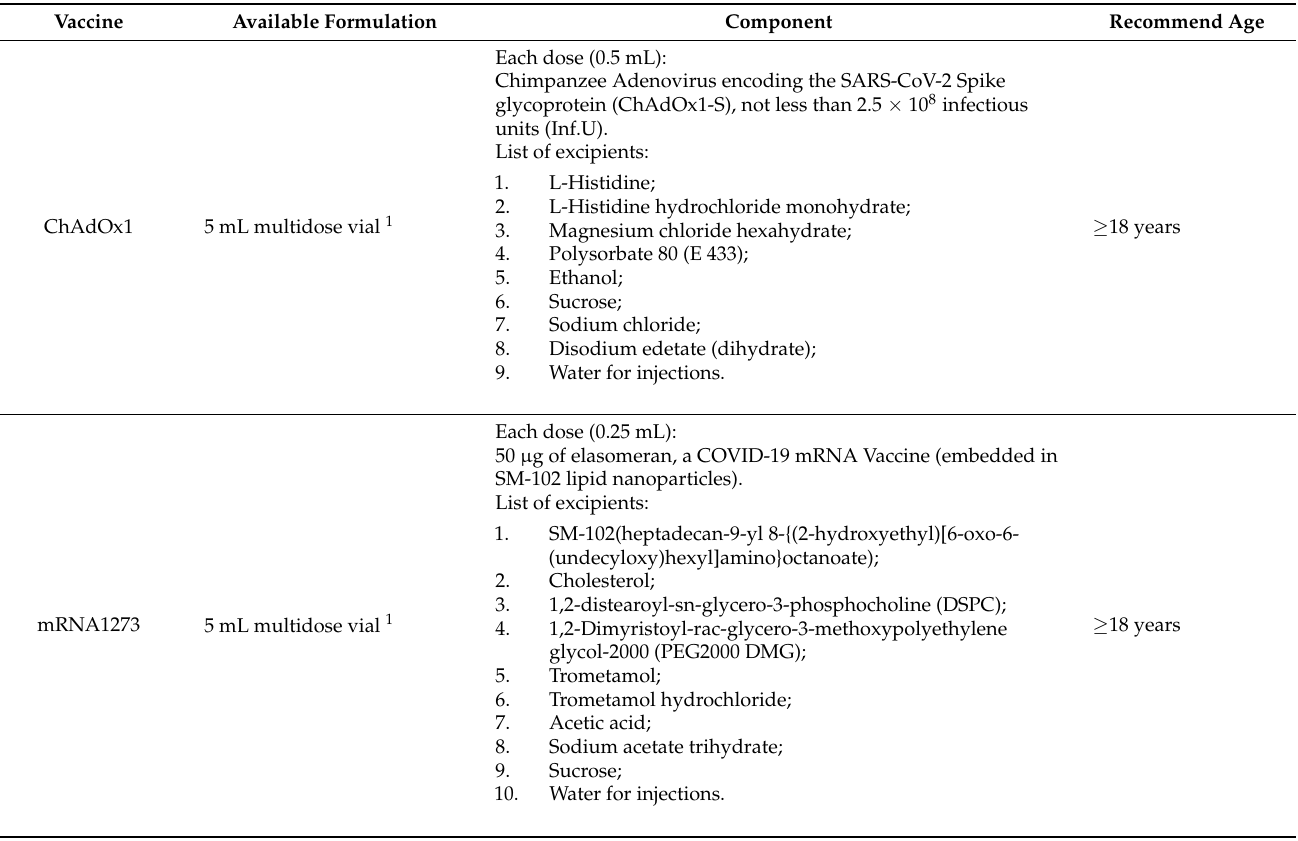
Table A1. The component and adjuvants of four brands of COVID-19 vaccines for booster dose *. Vaccine Available Formulation Component